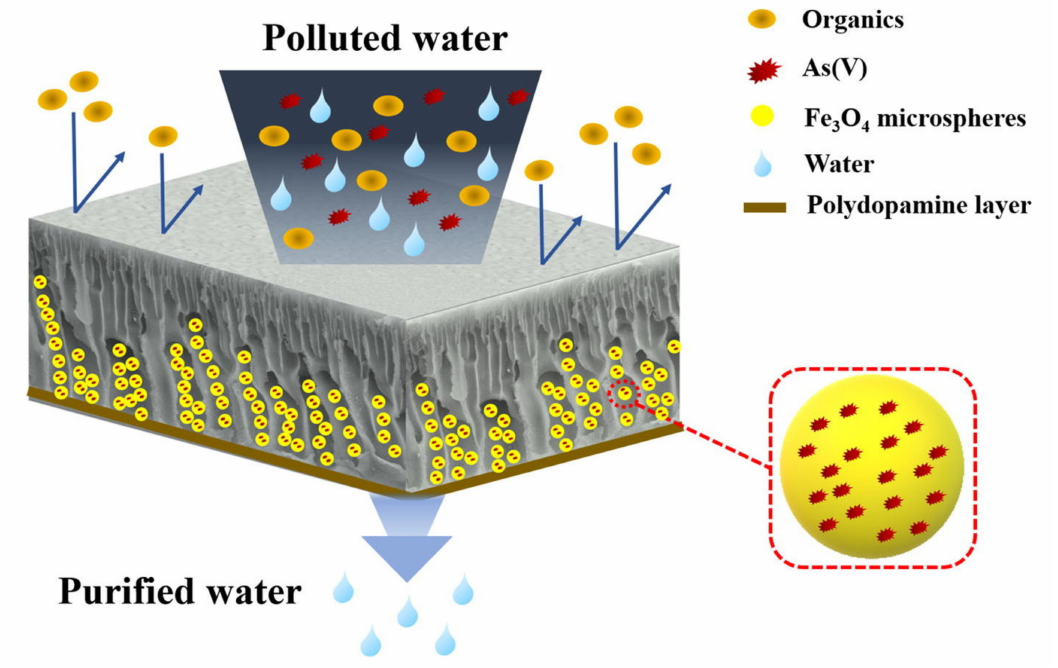
Figure 18. Illustration of adsorption, absorption, and rejection of organic micropollutants and arsenic on the surface and within the membrane pores modified with Fe 3 O 4 microspheres during a filtration-absorption process. Adapted from [179] with permission from